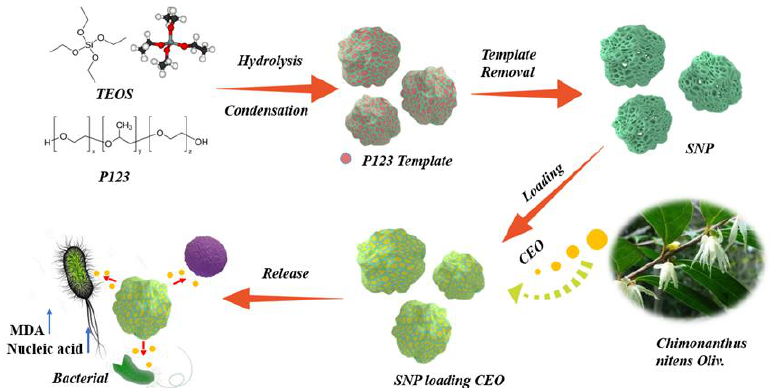
Figure 1. Schematic image of sponge-liked silica nanoporous particles loaded with Chimonanthus nitens Oliv . essential oil (CEO-SNP).